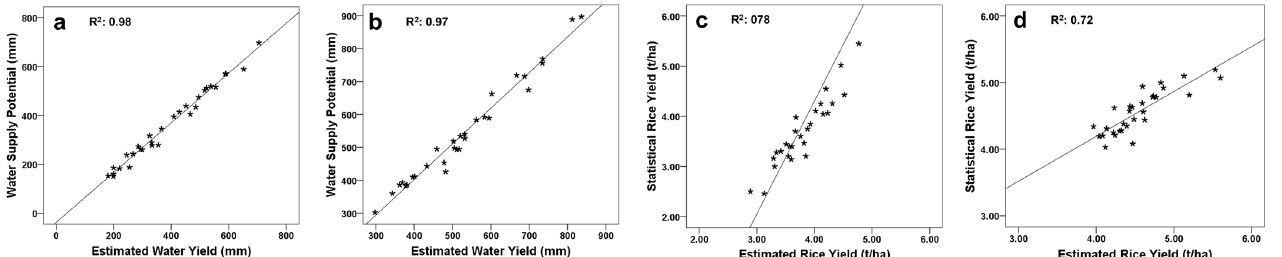
Figure 3. Evaluation results of each model and region: InVEST-WY for ( a ) North Korea and ( b ) South Korea; EPIC model for ( c ) North Korea and ( d ) South Korea.